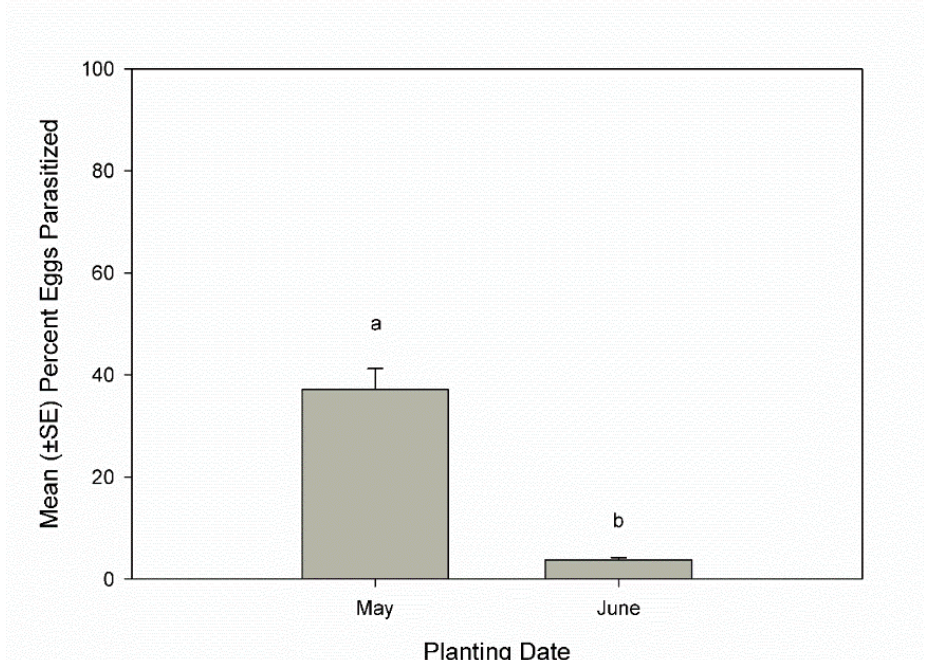
Figure 1. Mean (+SE) percent parasitism on egg masses in squash fields planted in May or June, 2016–2021, Beltsville, Maryland, USA. Weeks topped by the same letters were not significantly different (ANOVA: experiment-wise p ≤ 0.05).